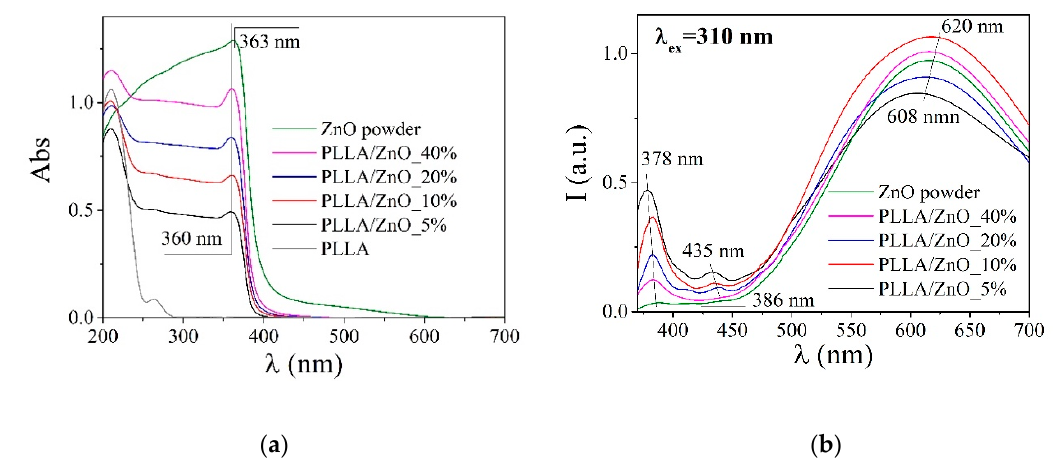
Figure 5. Absorption ( a ) and PL ( b ) spectra of prepared composite membranes. Spectra of laser-prepared ZnO NPs are given for